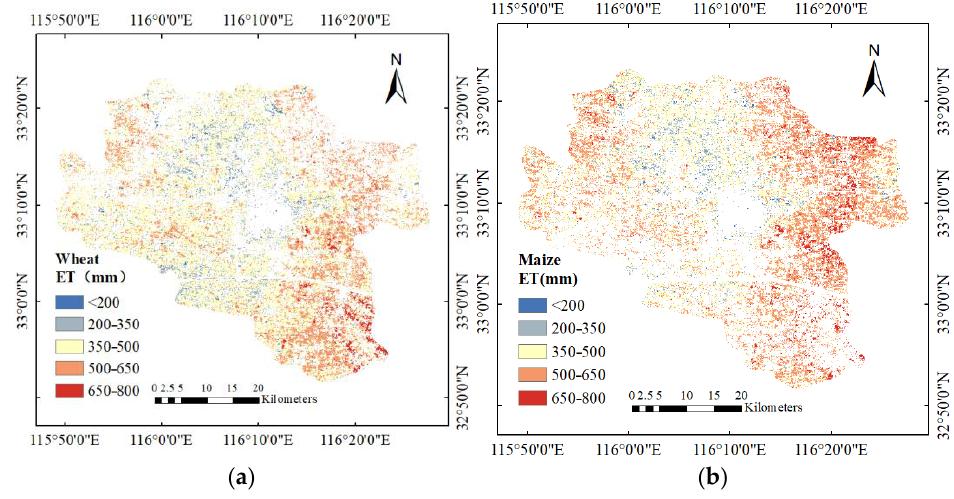
Figure 8. Spatial distribution of crop evapotranspiration. ( a ) Winter wheat; ( b ) Summer maize. To evaluate the prediction accuracy, the coefficient of determination (R 2 ), root mean square error (RMSE), and Nash – Sutcliffe efficiency coefficient (NSE) are chosen to analyze the ET. The ET 24-hour estimated by the SEBAL model and the measured ET obtained on the basis of the smart soil moisture monitoring instrument are shown in Figure 9. The RMSE is 0.56 mm/d, the R2 is 0.96, and the NSE is 0.90. Figure 9 shows that the estimated ET 24- hour results are consistent with the observed values.